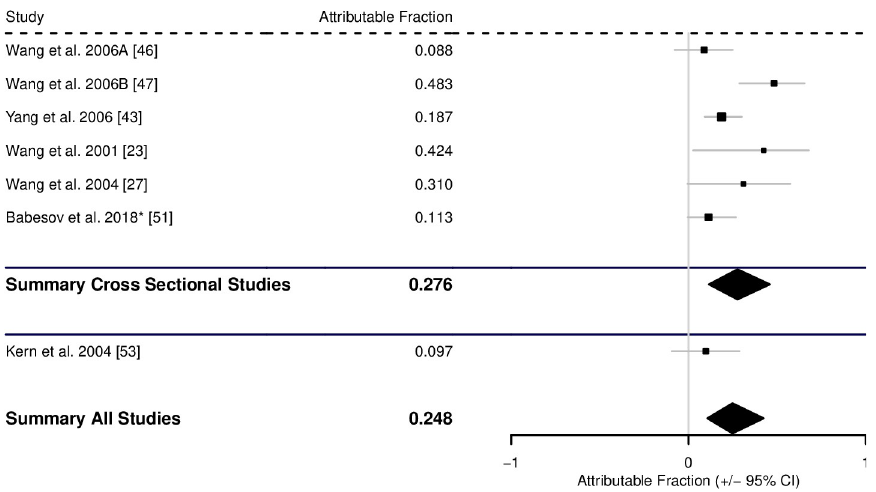
Fig 8. Forest plot for the attributable fraction for 6 cross-sectional studies and 1 case-control study that analysed contaminated water as a potential risk factor for human AE. � Data not reported in study, but supplied by the authors.